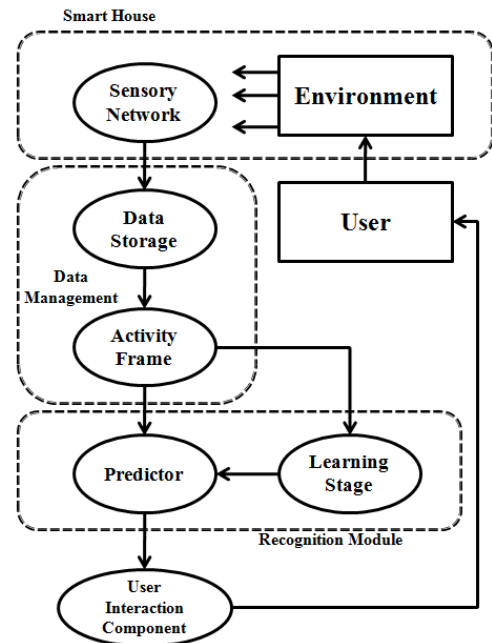
Figure 2: Overall structure of the proposed system. First, data is collect from different sensors, then organized and stored as a state of the environment. A sequence of instance is then compacted as a activity frame, to be used by the prediction layer, either during the training stage or for data recognition. Finally, the recognized activity is used by a interactive device, which will support the user on their daily life.